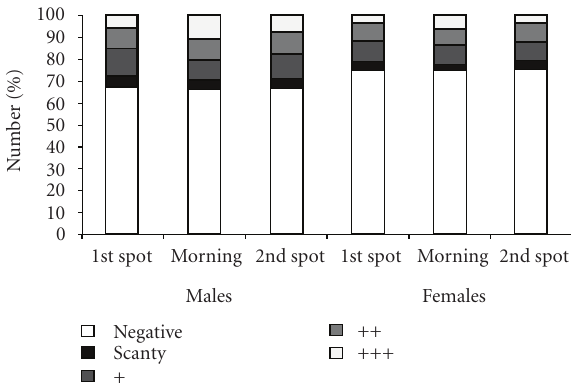
Figure 1: Smear grades of first spot, morning, and second spot sputum specimens by sex.